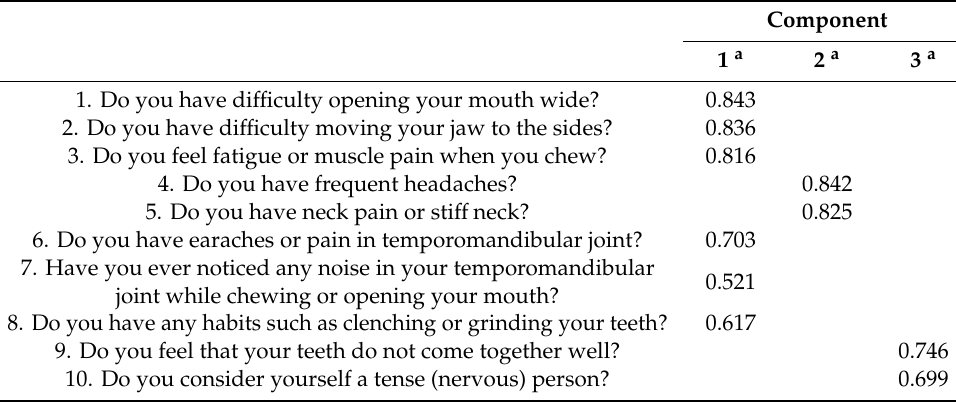
Figure 1. Scree plot for factorial analysis. Table 2. Rotated component matrix of the Fonseca anamnestic index (FAI) factor analysis.